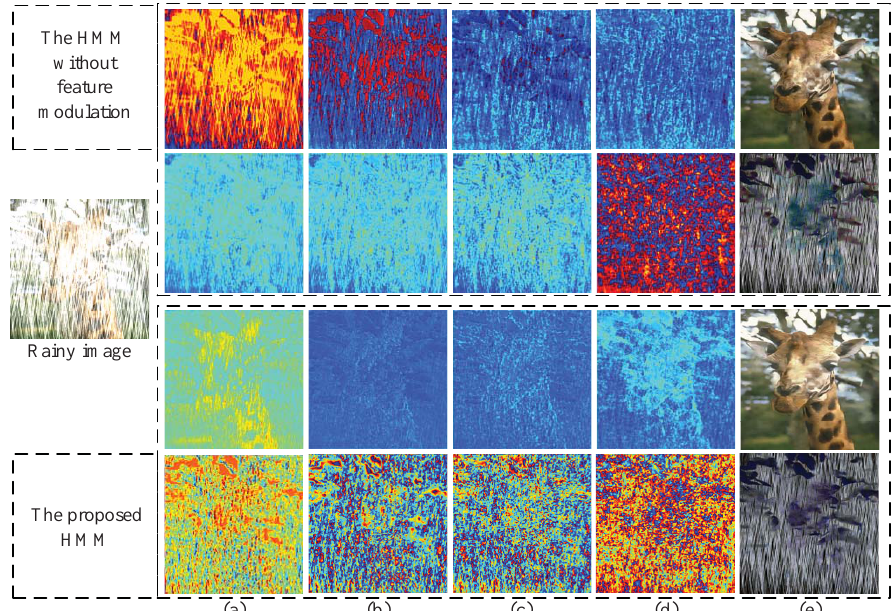
Figure 12. The first and second row show the visualization results of the rain-free layer and rain streak of the baseline (HMM without FM) , respectively. The third and fourth row display the visualization results of the rain-free layer and rain streak of the proposed PHMNet (HMM with FM) , respectively. The first column shows a rainy image. The results of other columns are from ( a ) 1st module, ( b ) 3rd module, ( c ) 5th module, ( d ) 7th module, ( e ) output of CR